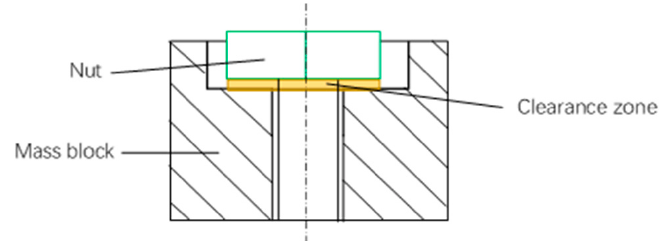
Figure 11. The schematic diagram of nut and mass block with clearance in dynamic analysis.